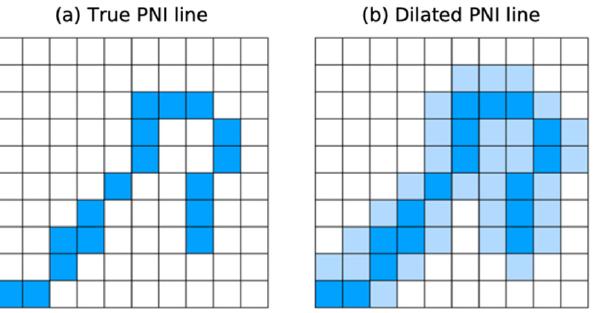
Figure 6. Boundary dilation. ( a ) true PNI line; ( b ) dilated PNI line with expansion width 1.